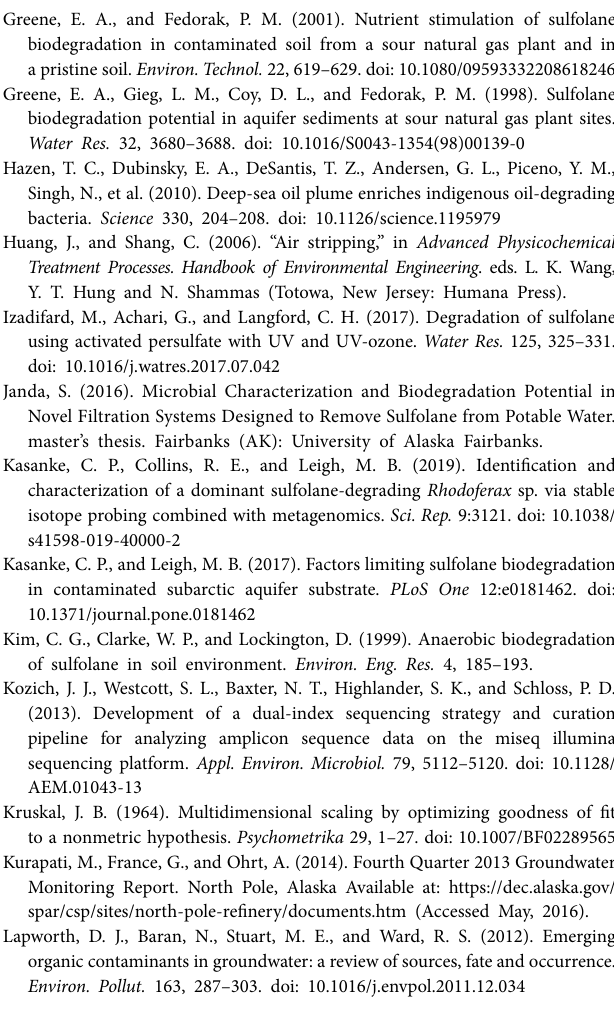
Supplementary Figure 1 | Layout of the experimental air-sparge system. Supplementary Figure 2 | Schematic of the granular activated carbon remediation